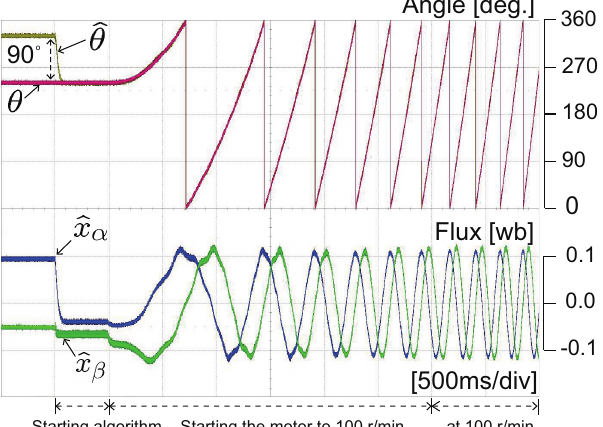
Figure 7. Angle and active flux estimation at the starting under no load condition when the initial angle error is 90 ◦ .